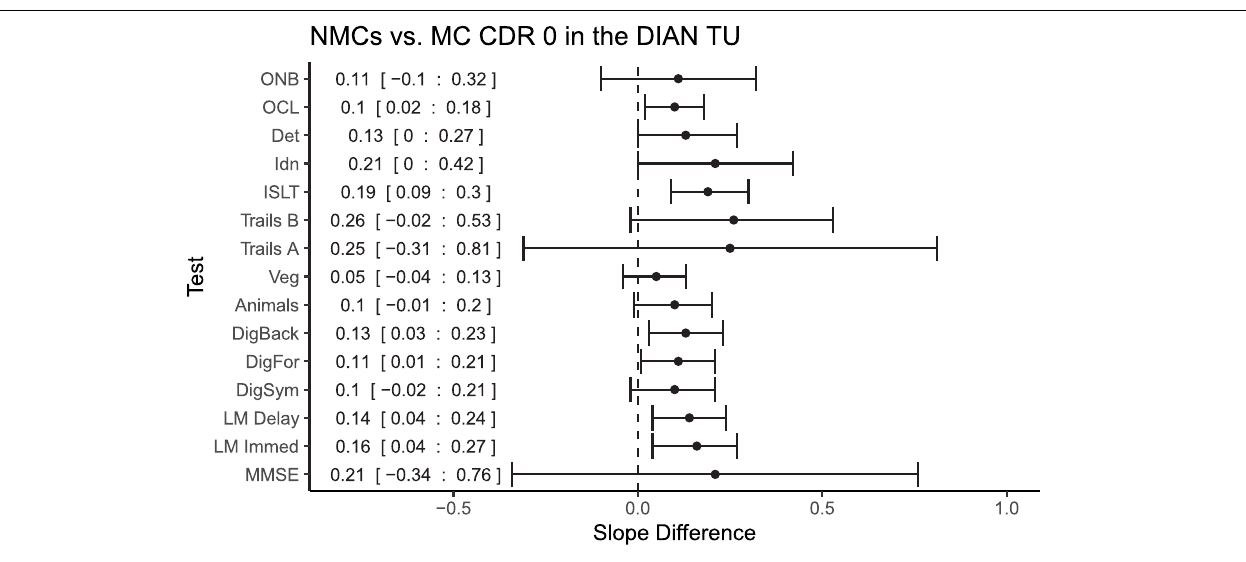
FIGURE 2 | Differences in slopes (and 95% CIs) for each test between non-carriers and CDR 0 mutation carriers in the clinical trial (TU). A positive slope difference indicates a larger or more positive slope (improvement) in the non-carriers compared to mutation carriers. Mean difference and 95% confidence intervals are pasted along the left